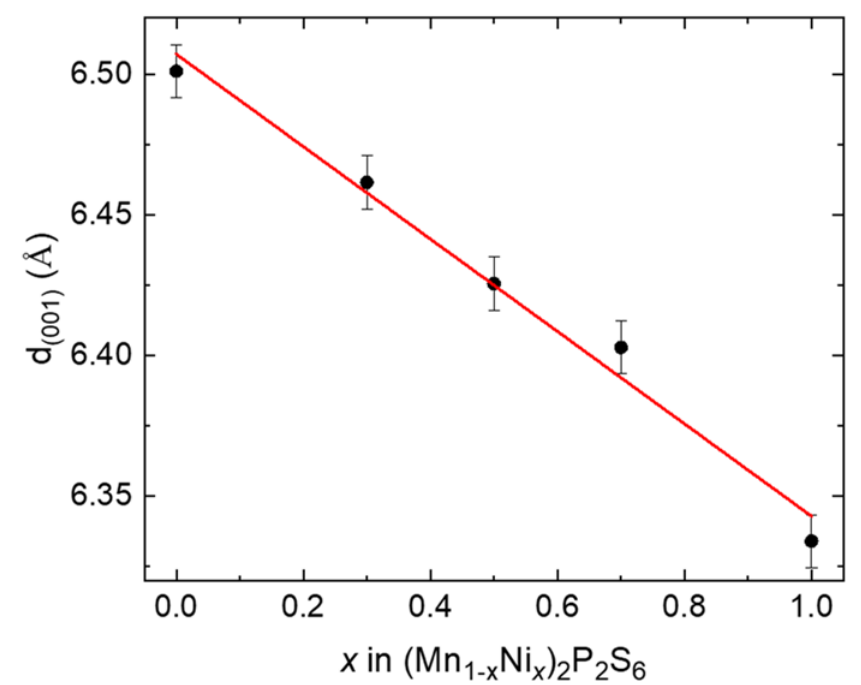
Figure 4. Interlayer spacing d calculated from Bragg’s law and plotted as a function of Ni substitution for (Mn 1 − x Ni x ) 2 P 2 S 6 .